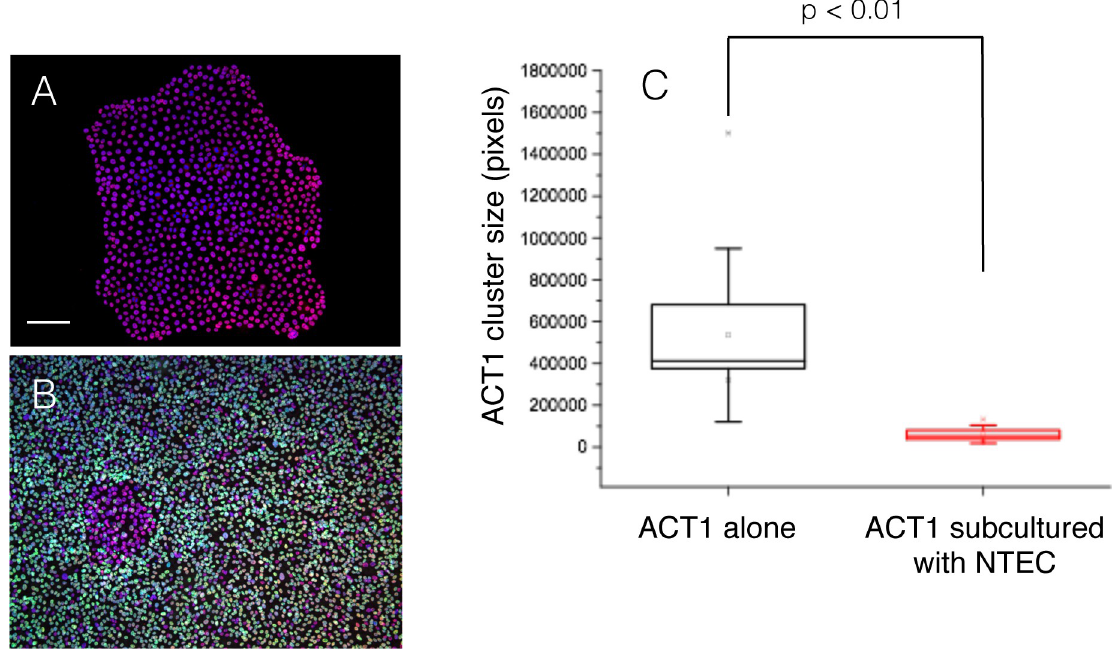
Fig 2. Suppression of ACT1 cell growth by competition with NTECs. ACT1 cells were cultured for 5 days until they formed small cell clusters, and then GFP-NTECs were added and cultured for 3 more days. ACT1 cluster sizes at Day 8 were measured in ATC1 monocultures (A) and in co-cultures (B), and their sizes were compared (C) as described in Materials and Methods. ACT1 clusters and NTECs were fixed and stained with anti-53BP1 antibody (red fluorescence). The bar indicates 100 μ m.